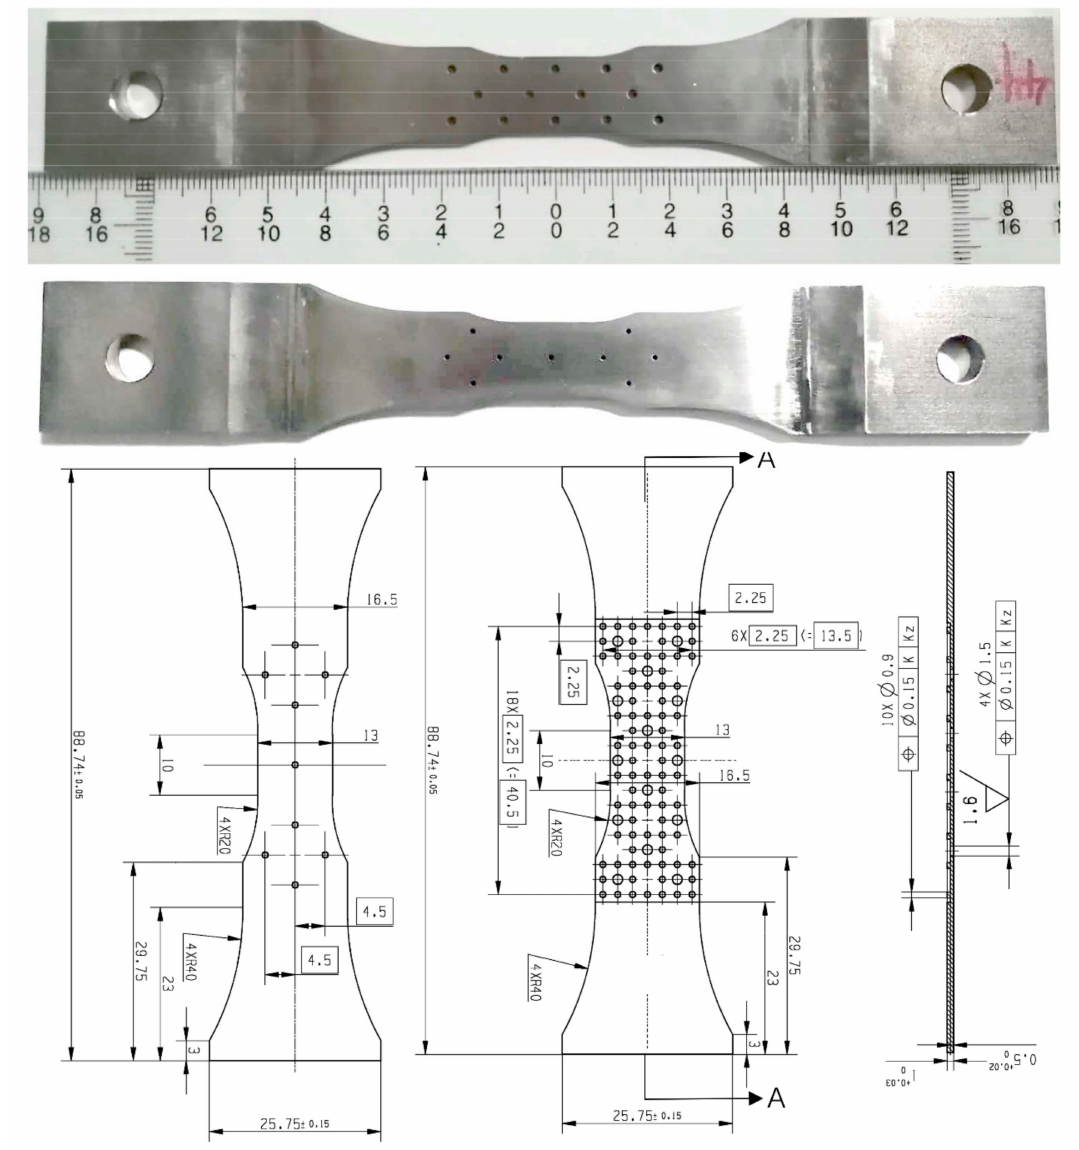
Figure 2. Physical picture and geometry schematic of the specimens (unit: